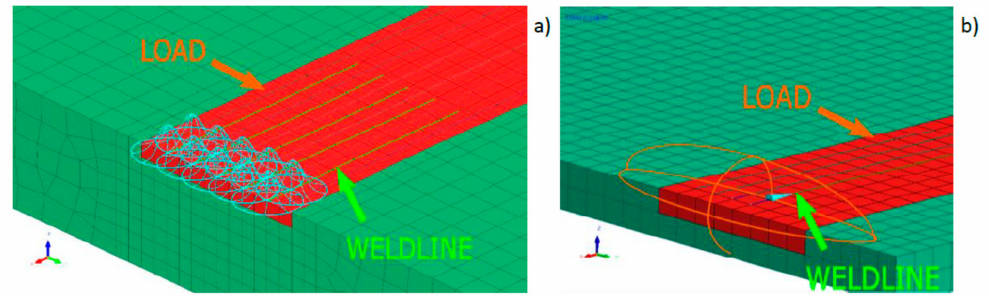
Figure 21. View of loading of the elements of the model mesh and placement of ( a ) heat source models with a normal distribution (Gaussian surface heat source model) and ( b ) a double-ellipsoid heat source